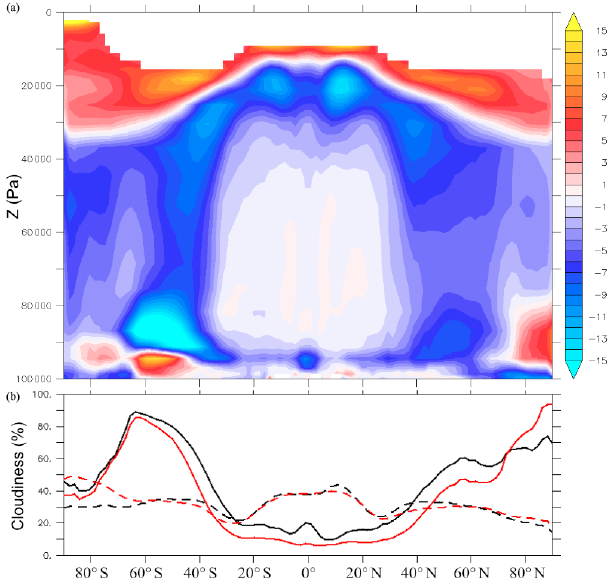
Figure 5. Mean annual cloudiness for 1X-NOICE and 4X-NOICE simulations. (a) Anomaly of total cloudiness (4X-NOICE − 1X NOICE). (b) Low-altitude cloudiness (below 680hPa of atmo- spheric pressure – solid curves) and high-altitude cloudiness above 440hPa of atmospheric pressure – dashed curves) for 1X-NOICE (black) and 4X-NOICE (red) simulations.